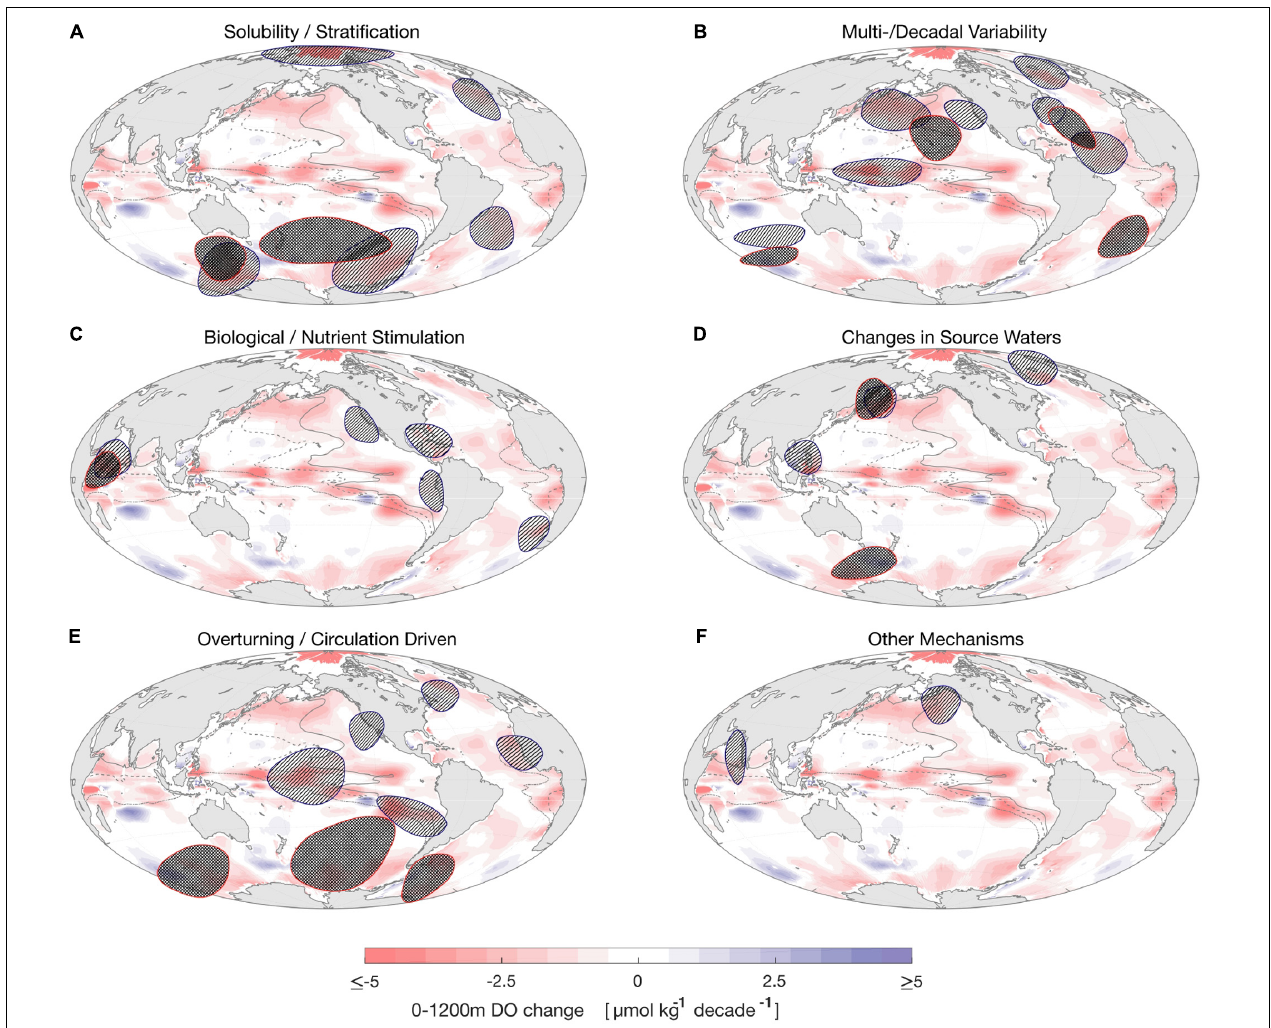
FIGURE 5 | Major drivers of regional oxygen variability marked as approximate areas as described in peer-reviewed articles from observations and model analyses (see details in Stramma and Schmidtko, 2021). Background colors indicate upper ocean oxygen changes in µ mol kg − 1 decade − 1 . The areas with significant variability from (A) solubility and/or stratification, (B) multi-decadal or decadal variability, (C) biological and/or nutrients stimulation, (D) changes in source waters, (E) overturning and/or circulation driven, and (F) other mechanisms. The diagonal-hatched regions indicate upper ocean impact, the cross-hatched regions indicate deep ocean variability. (reworked after Stramma and Schmidtko,